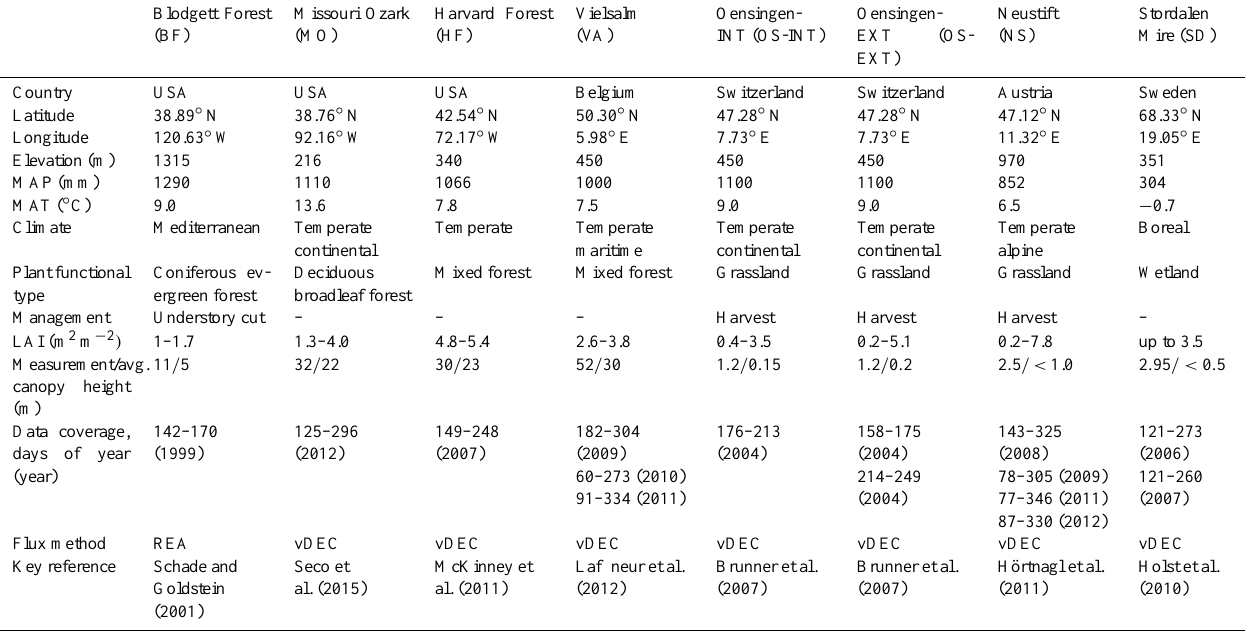
Table 1. General characterisation of the study sites (see Table S1 for further details on experimental setup). Blodgett Forest